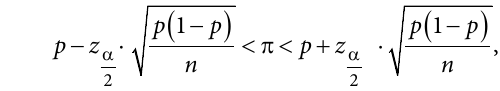
table, area chart and 3D bar chart were applied. In data analysis selected methods of statistical inference were used. Interval estimates of the population proportions and hypotheses testing (test about a population proportion and test about the difference between two population proportions) were